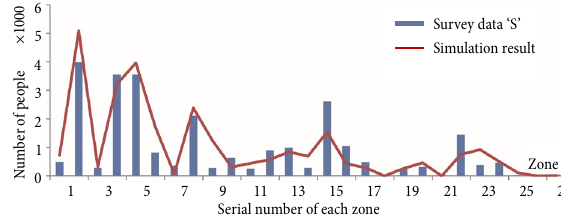
Fig. 5. Survey data and simulation results for shopping activity location choices using the multi-agent-based